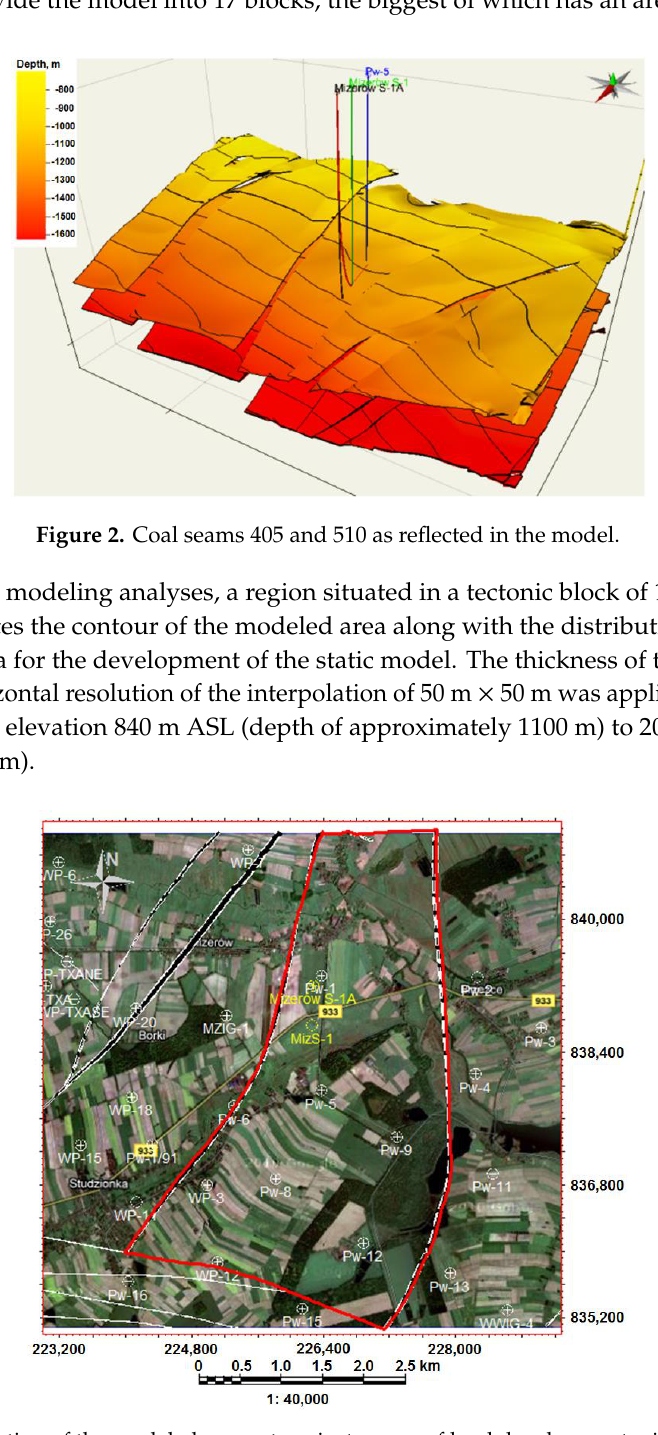
Figure 3. The location of the modeled area set against a map of land development with the designated wells, archival bore holes and tectonic blocks.